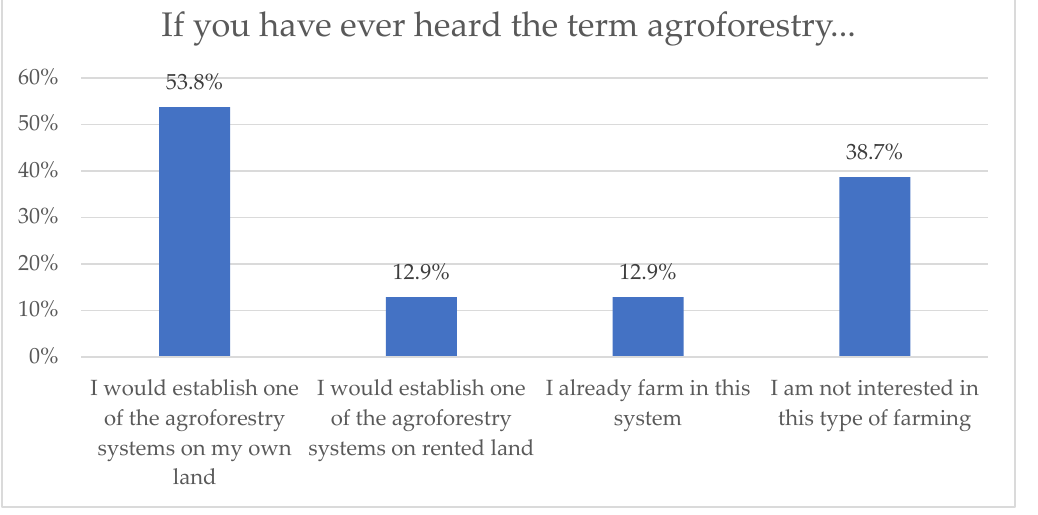
Figure 4. Willingness to establish agroforestry systems (multiple choice; n = 93).